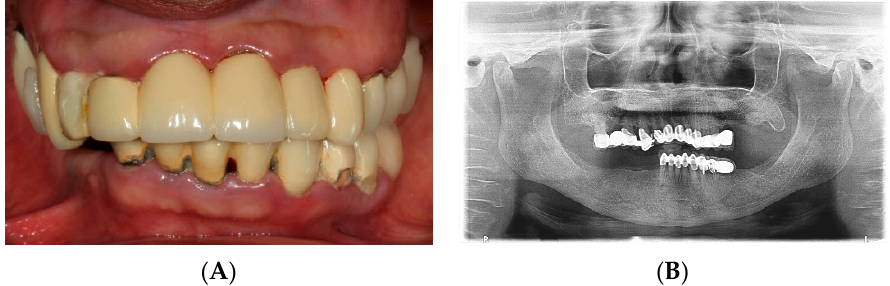
Figure 1. Initial examination. ( A) Clinical presentation. ( B) Panoramic radiograph.